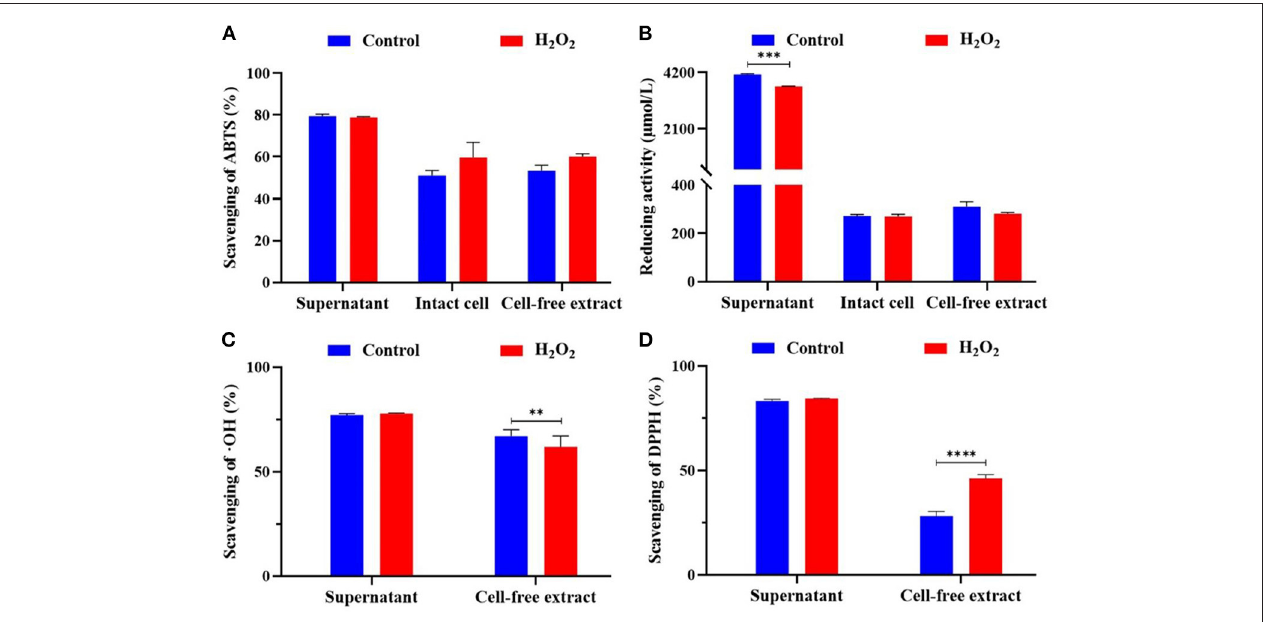
FIGURE 3 | The antioxidant activity of L. plantarum KM1 different components. Scavenging of ABTS (%) (A) , reducing activity ( µ mol/L) (B) , scavenging of OH (%) (C) , and scavenging of DPPH (%) (D) . Free radical scavenging ability and reducing ability of fermentation supernatant minus the corresponding antioxidant evaluation of MRS medium itself. Control, the normal group; H 2 O 2 , hydrogen peroxide intervention group. ** p < 0.01, *** p < 0.001, and **** p <